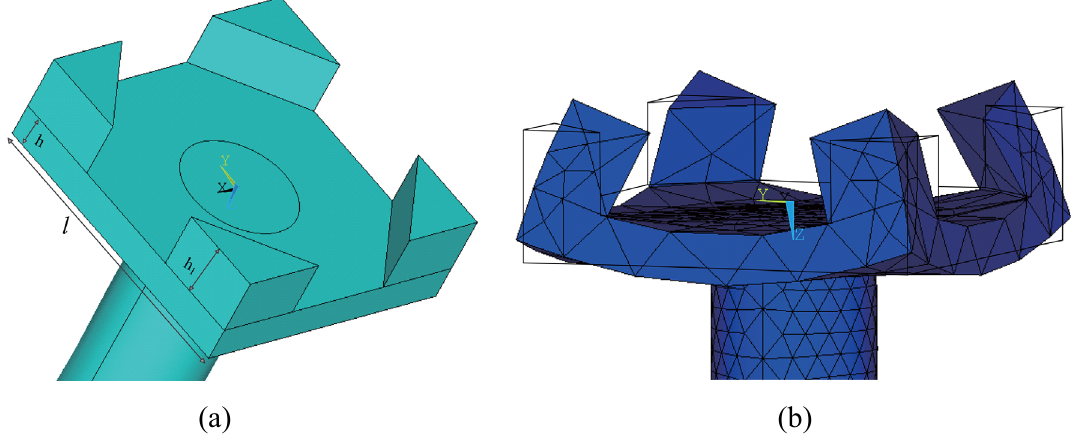
Figure 4. A square stepped plate and its response vibration mode. (a) The stepped plate, (b) the vibration mode at f e2 = 15,751 Hz.